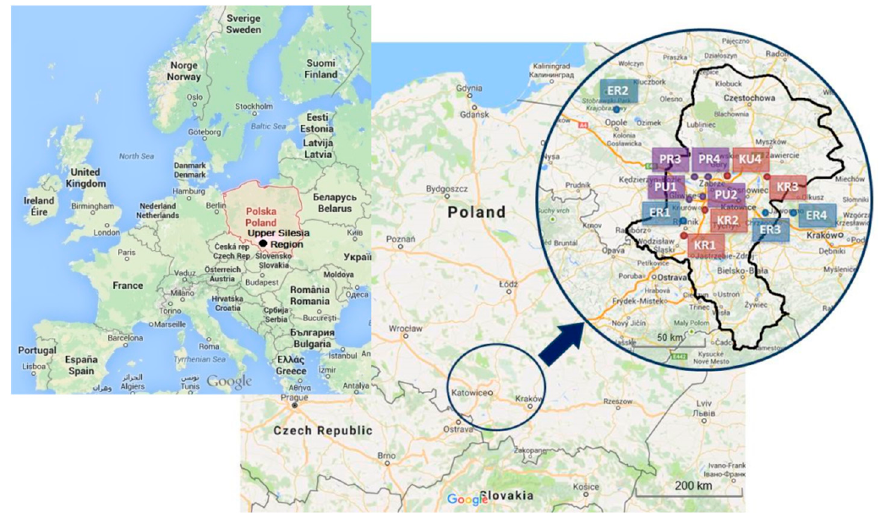
Figure 1. Locations of measurement points (map data: ©2013 GeoBasis ‐ DE/BKF (©2009), Google).